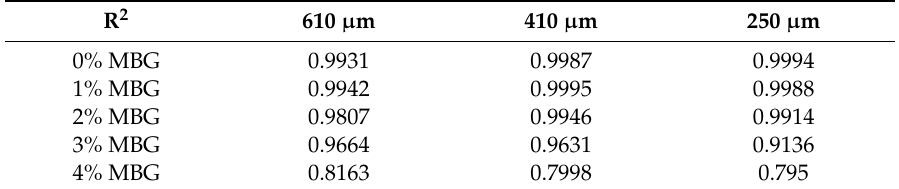
Table 3. Coe ffi cients of determination of the linear fitted mass flow profiles dependent on di ff erent needle types (Figure